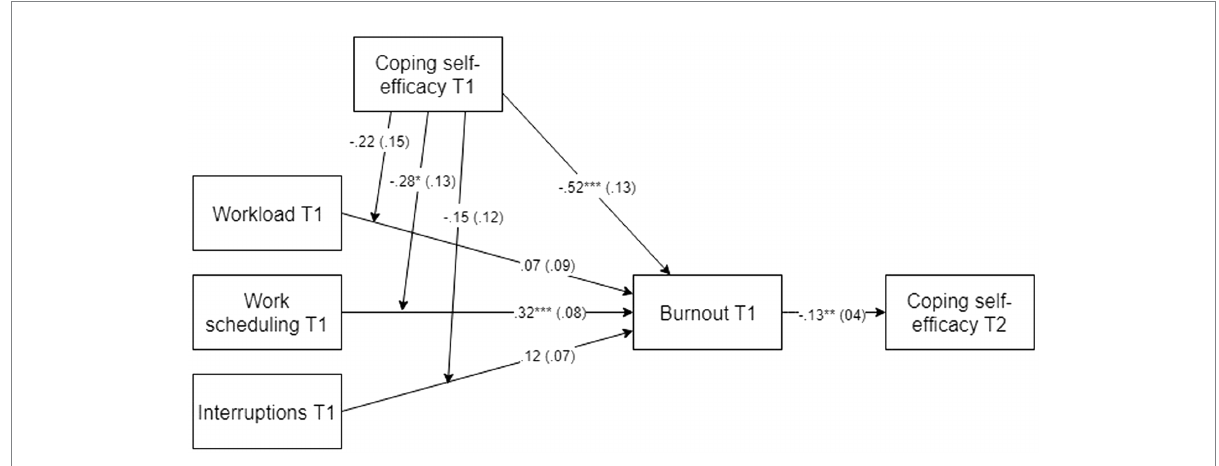
FIGURE 1 Final model. Direct path coefficients (unstandardised b ) and moderations are presented with SE in parentheses. N = 166, * p < 0.05, ** p < 0.01, *** p < 0.001, T1 = Time 1, T2 = Time 2. Results from three separate analyses (per stressor and its interaction with coping self-efficacy) were combined into this